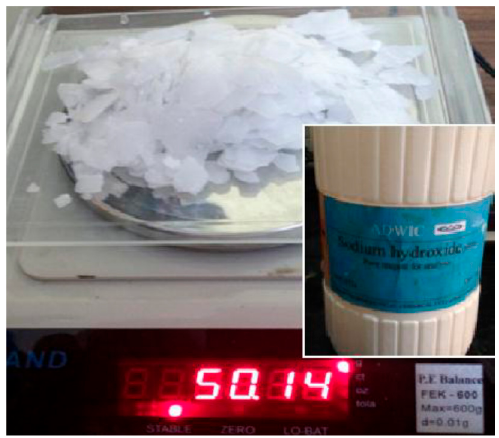
Figure 2. Sodium hydroxide alkali treatment.